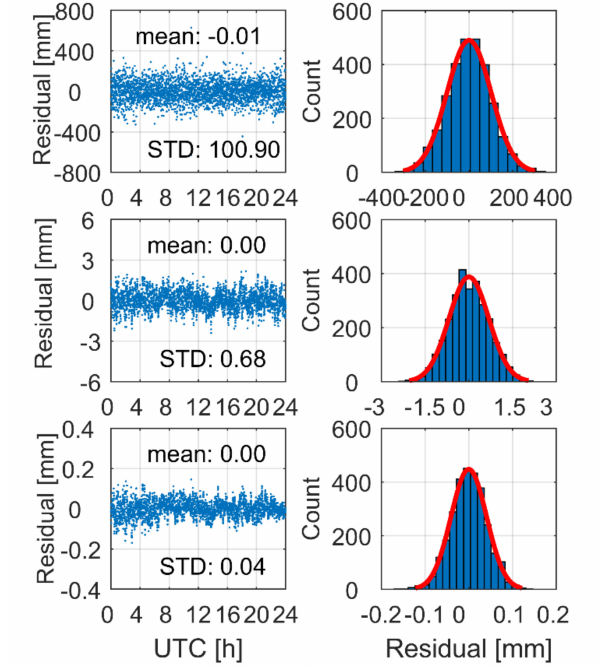
Figure 10. BDS RCB residuals with the STDs of the process noise set to 10 m (top), 0.74 mm (middle), and 0.001 mm (bottom). The data were collected from baseline IGG1–IGG2 on DOY 270,